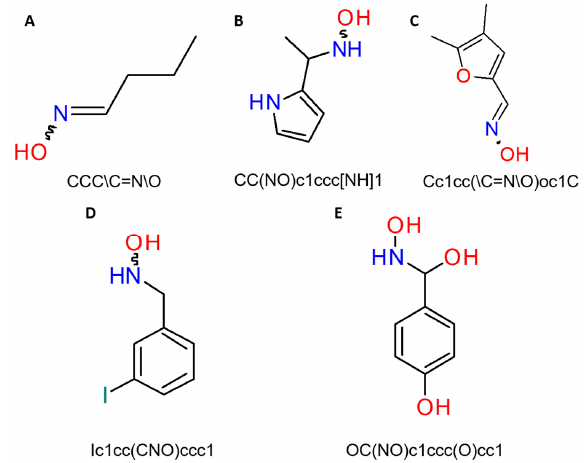
Figure 9. Promising compounds ( A ) M01 (ZINC13514543); ( B ) M02 (ZINC14413017); ( C ) M03 (ZINC05680928); ( D ) M04 (ZINC04691148); ( E ) M05 (ZINC95851150). Source: authors.